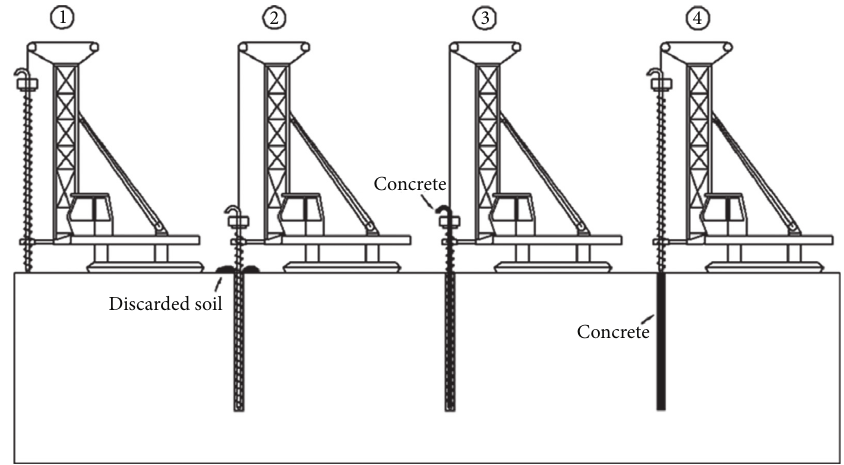
Figure 1: Construction process of CFG